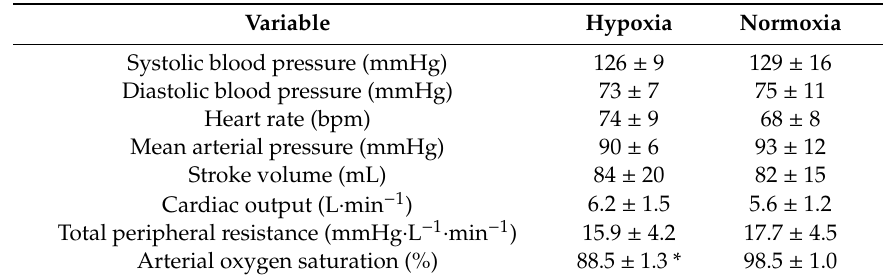
Table 2. Average values for hemodynamics variables for the last minute of the five cycles of intermittent hypoxia and intermittent normoxia.